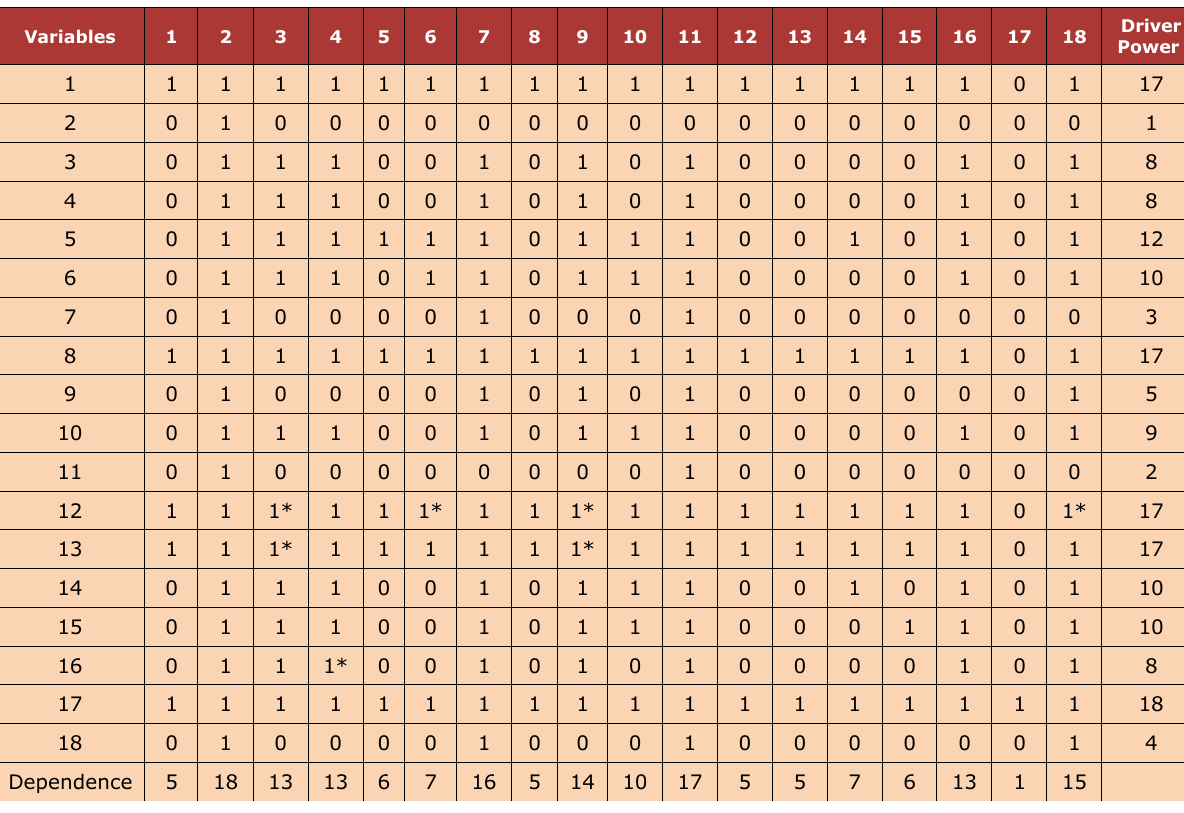
Table 6. Final Reachability Matrix